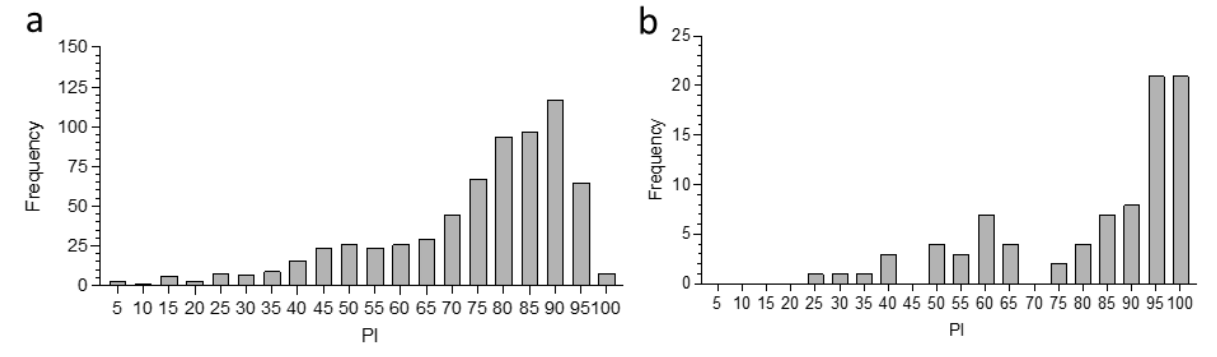
Figure 2. Distribution of PC-ELISA percentage inhibition (PI) values for serum from all camels and sheep sampled during the present study at sites in Marsabit, Laikipia, and Machakos counties, and camels sampled at sites in Isiolo and prior to slaughter at Athi River in 2015; ( a ) camels ( n = 679); ( b ) sheep ( n = 90).